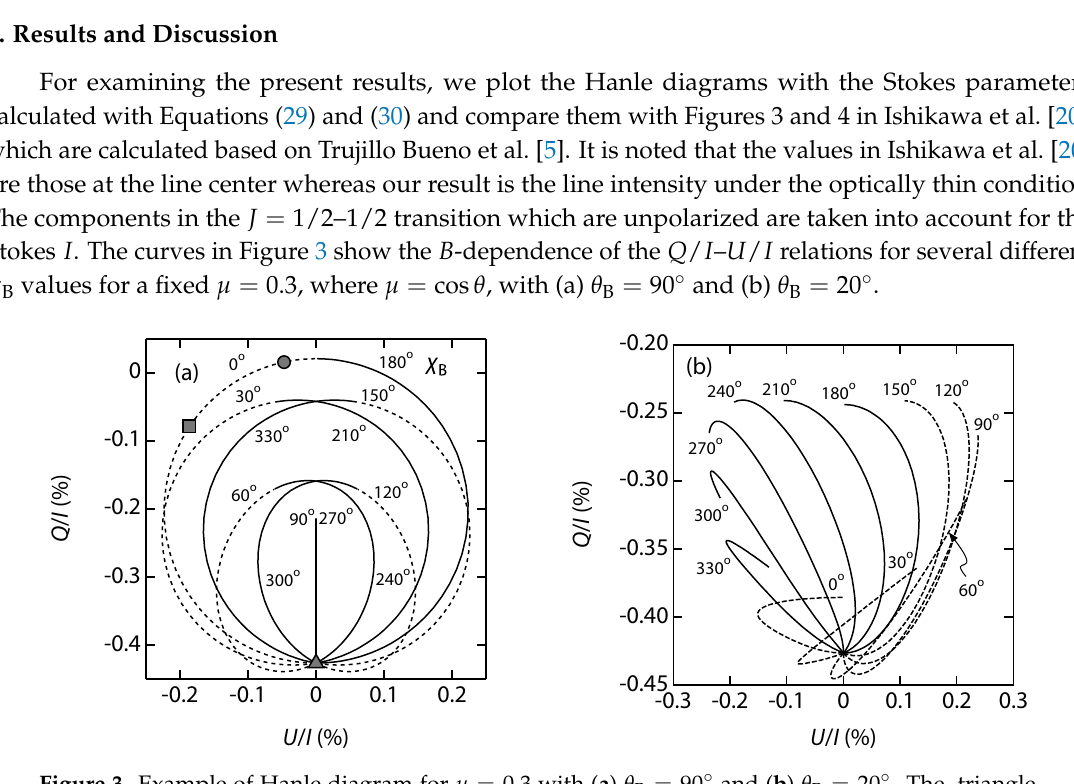
Figure 3. Example of Hanle diagram for µ = 0.3 with ( a ) θ B = 90 ◦ and ( b ) θ B = 20 ◦ . The triangle, square, and circle in ( a ) indicate the points at B = 0G, B = 50G, and B = 250G,